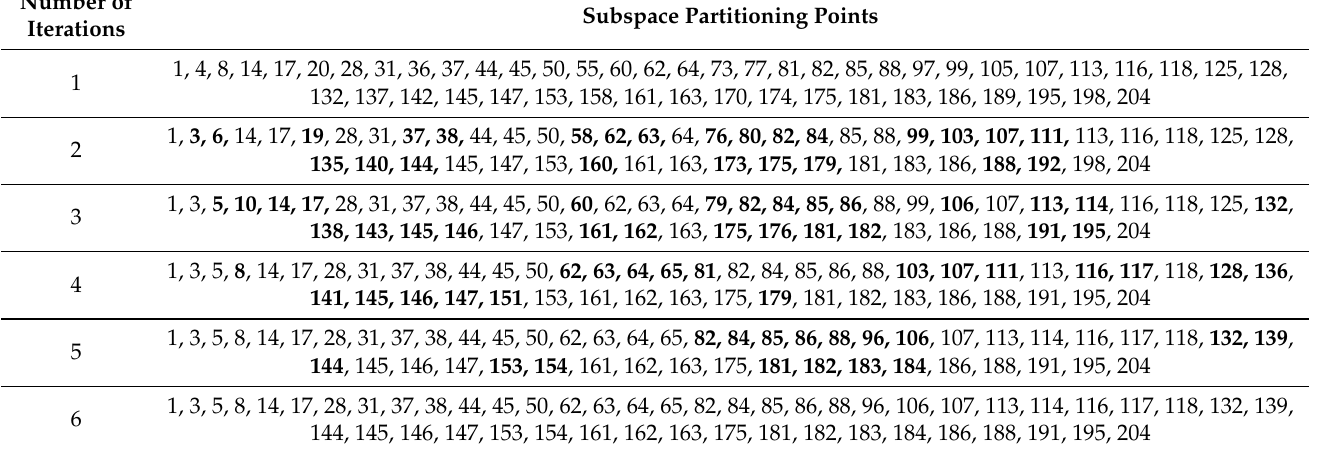
Table 1. Subspace grouping results of different iterations. The bold part in the second column indicates the partitioning points of the change.